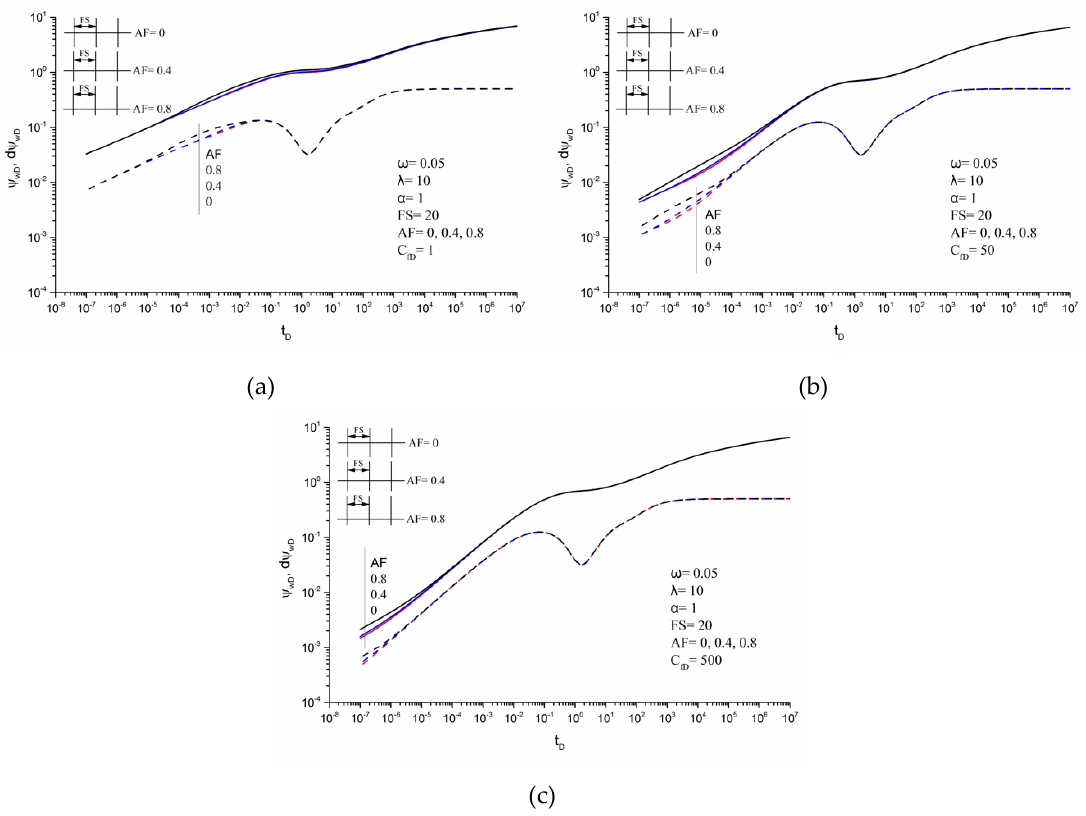
Figure 11. The typical pseudo-pressure curves of a multi-fractured horizontal well with different asymmetry factor. ( a ) low conductivity; ( b ) intermediate conductivity; ( c ) high conductivity.